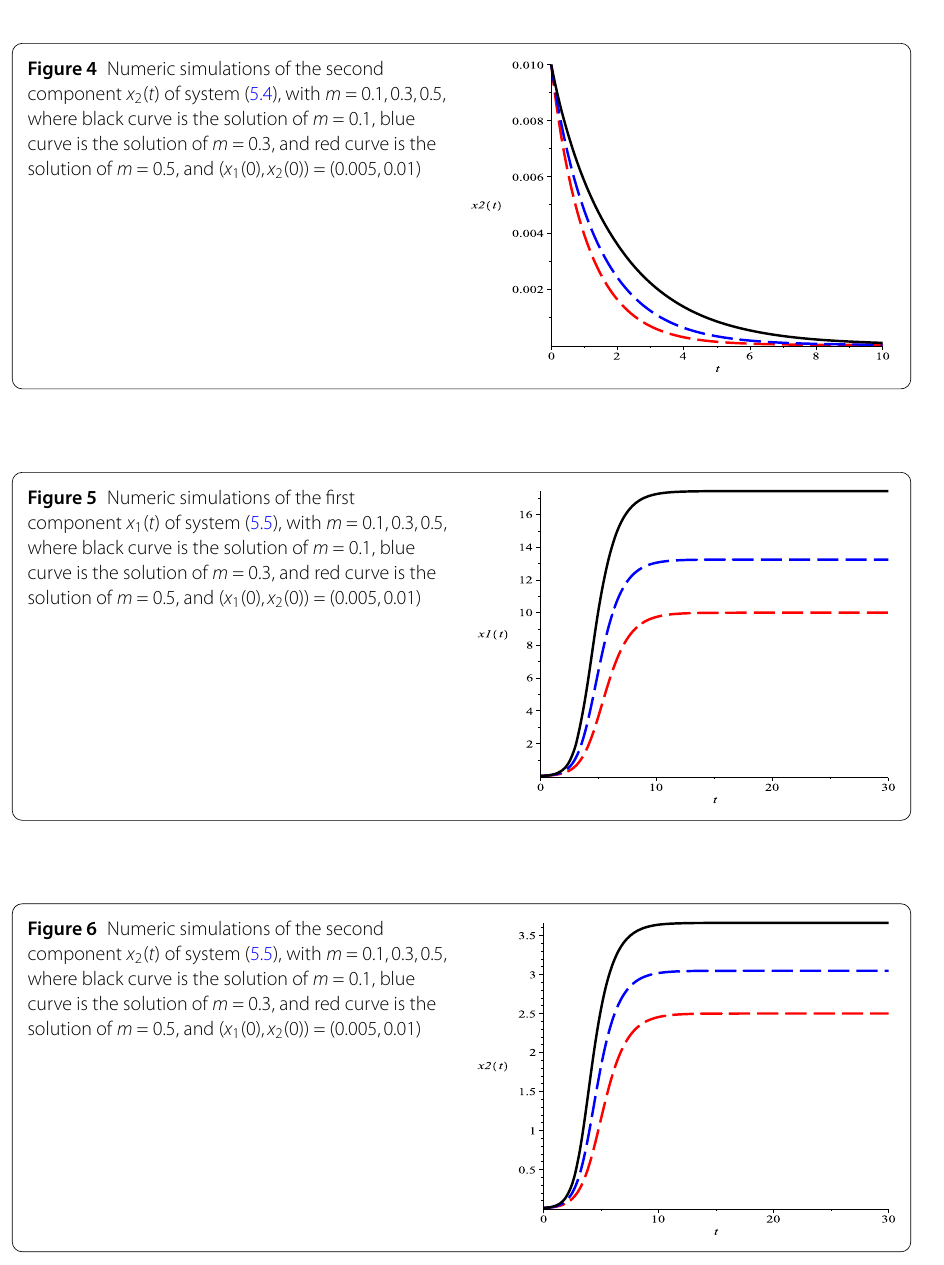
Figure 4 Numeric simulations of the second component x 2 ( t ) of system (5.4), with m = 0.1,0.3,0.5, where black curve is the solution of m = 0.1, blue curve is the solution of m = 0.3, and red curve is the solution of m = 0.5, and ( x 1 (0), x 2 (0)) = (0.005,0.01)